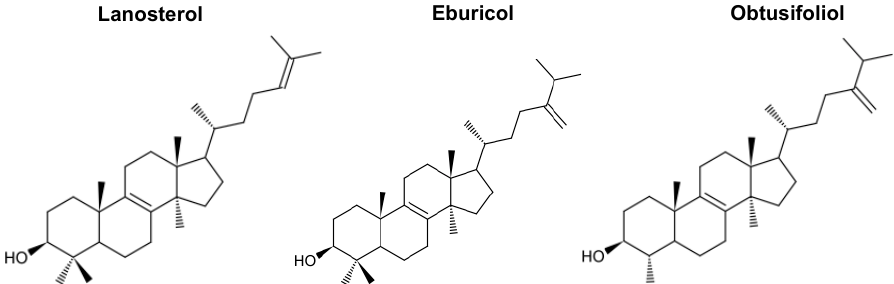
Figure 3. The structures of CYP51 substrates.